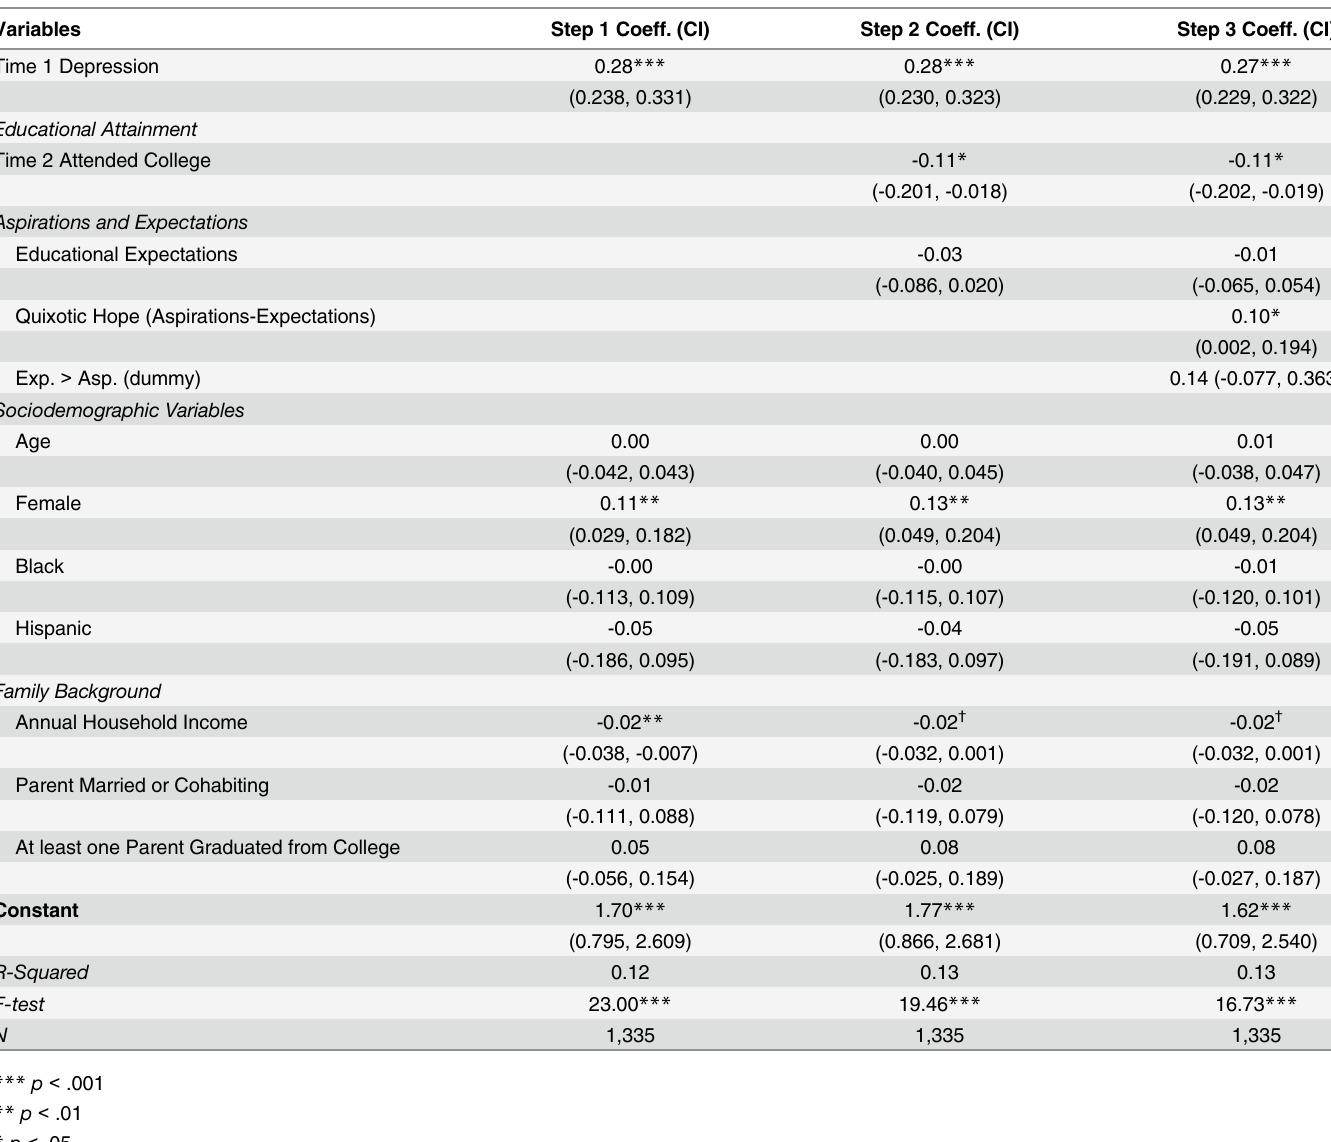
Table 8. Results of regression analyses for Study 2 Time 2